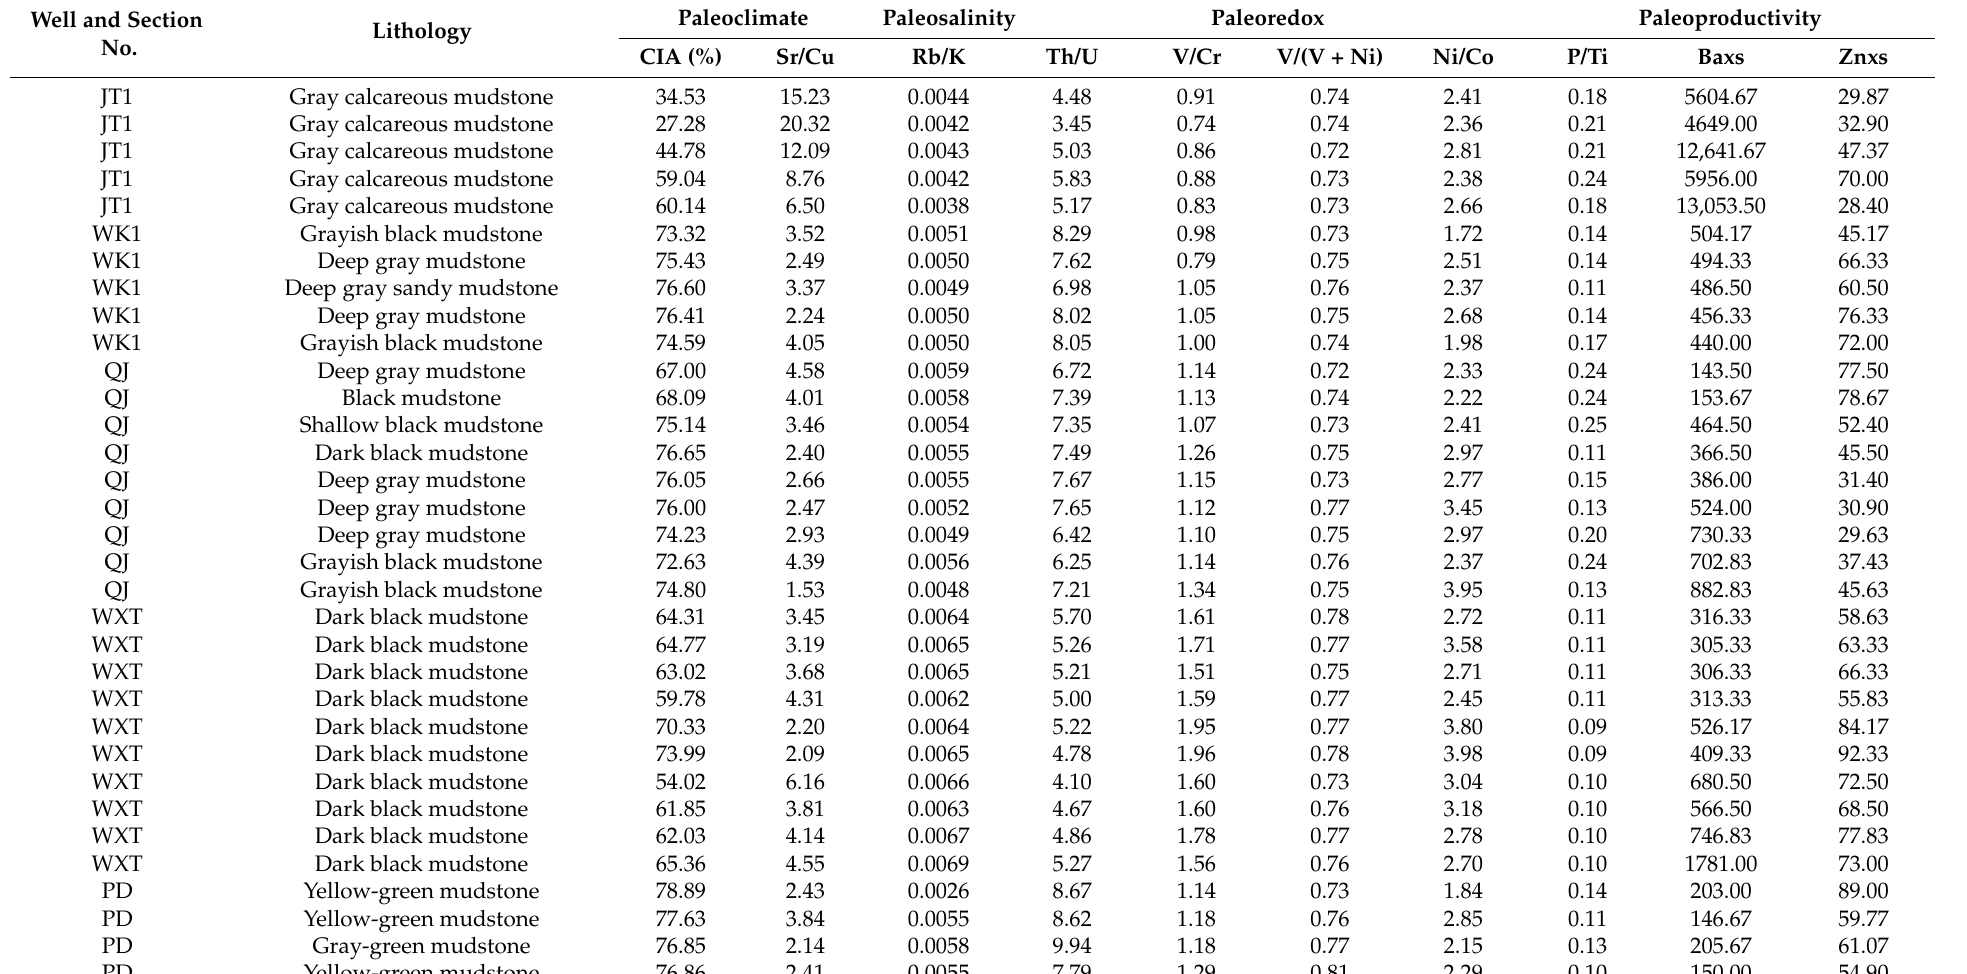
Table 3. Paleoenvironmental indicators of shale in the Meitan